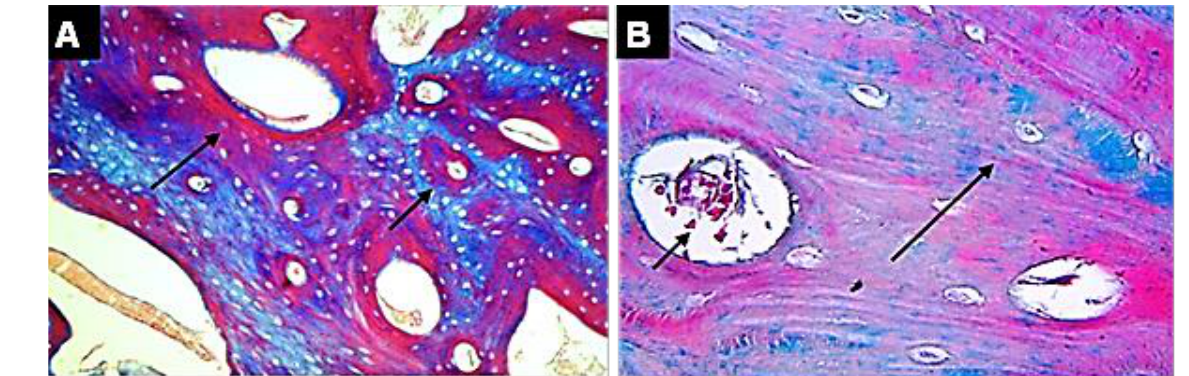
Figure 9. Histopathological section in treated group at 12 th weeks post-operation, (A) Trabecular and compact bone tissue (arrow), (B) compact bone (Masson’s trichrome,